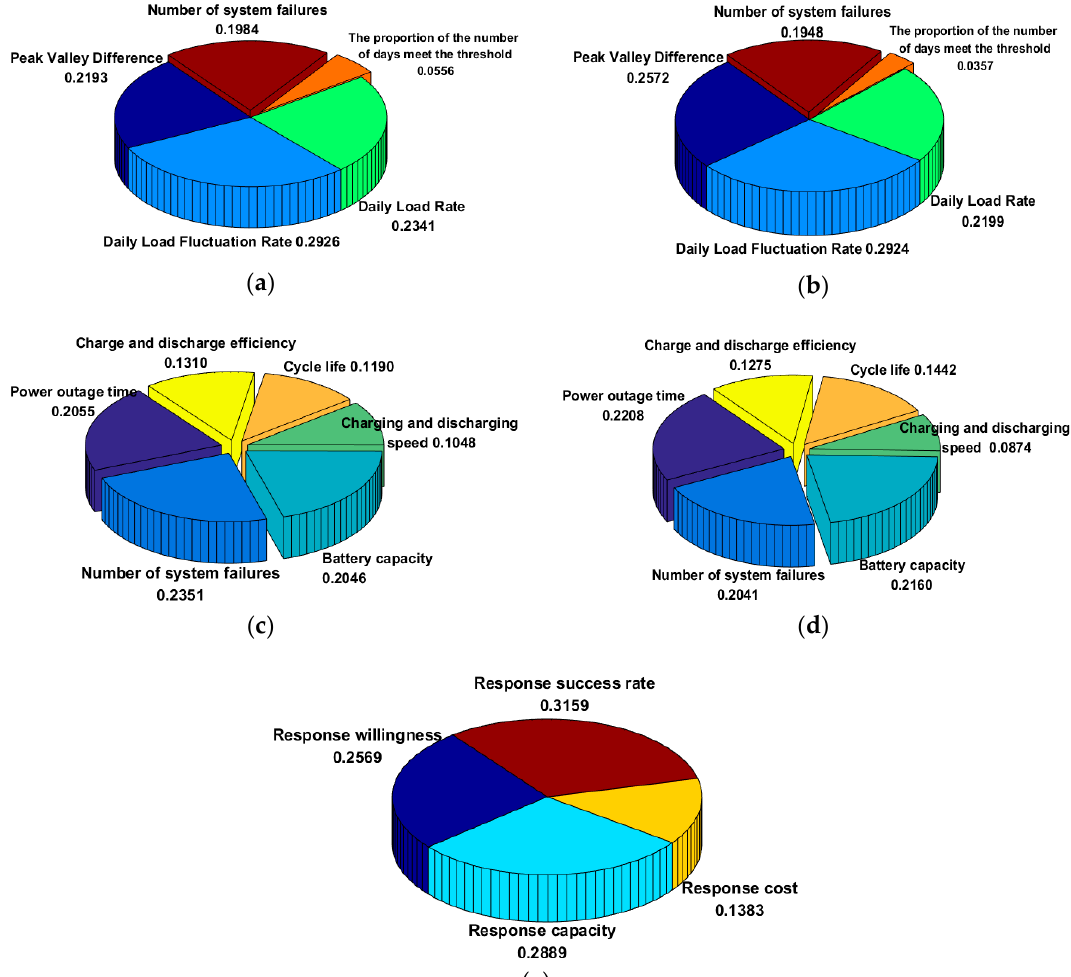
Figure 10. The weight of individuality indexes of various DSER. ( a ) The weight of indexes of WG; ( b ) The weight of indexes of photovoltaic (PV); ( c ) The weight of indexes of EV; ( d ) The weight of indexes of energy storage (ES); ( e ) The weight of indexes of flexible loads.